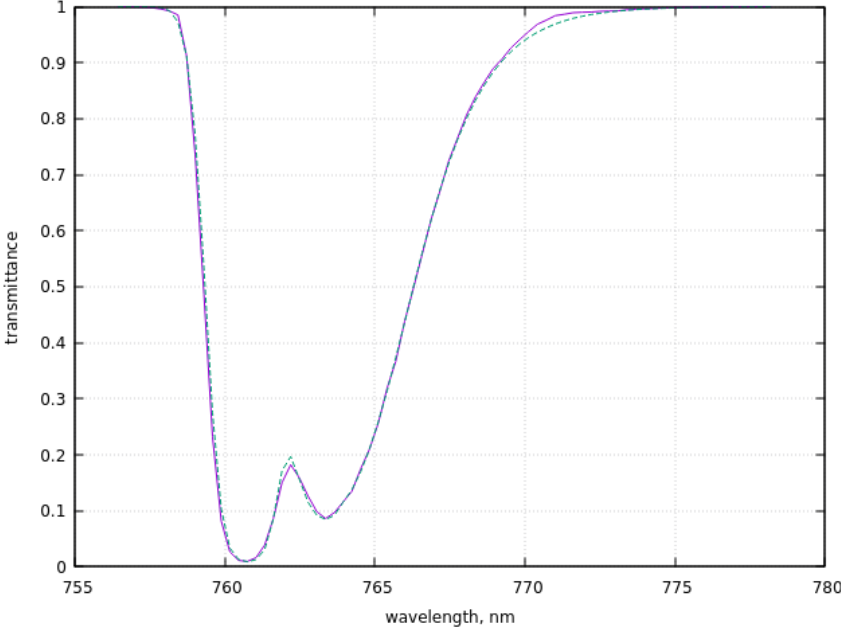
Figure 6. The oxygen transmittance (solid line—the tabular data given in [30] are used, dashed line—Equations (63) and (64) for the spectral function are used).